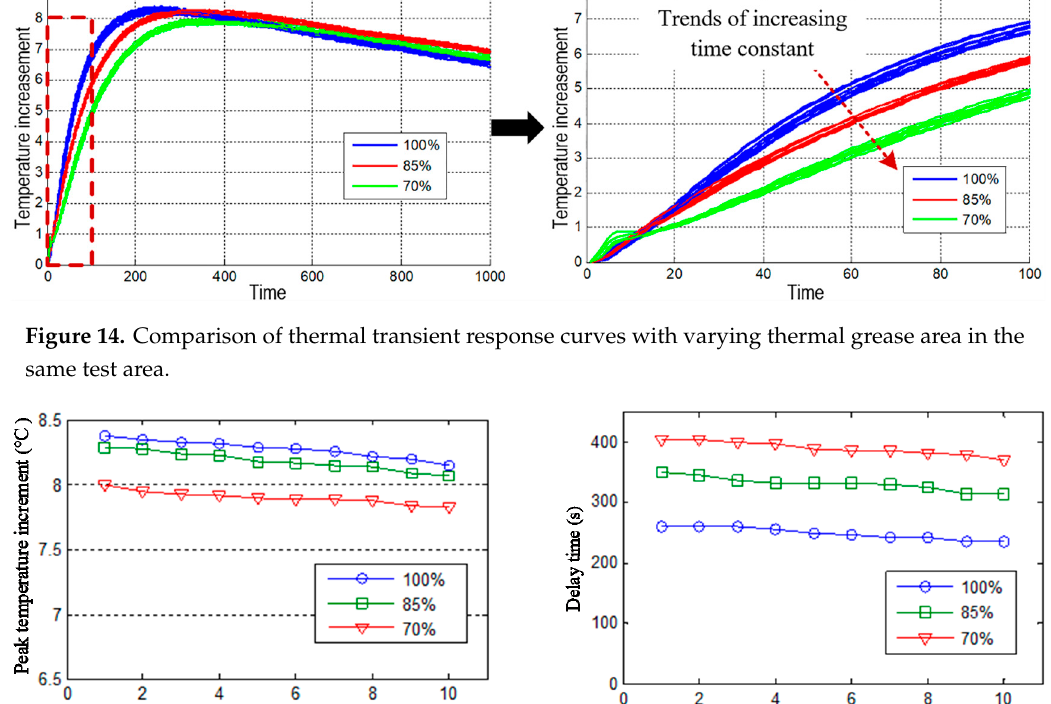
Figure 14. Comparison of thermal transient response curves with varying thermal grease area in the same test area.